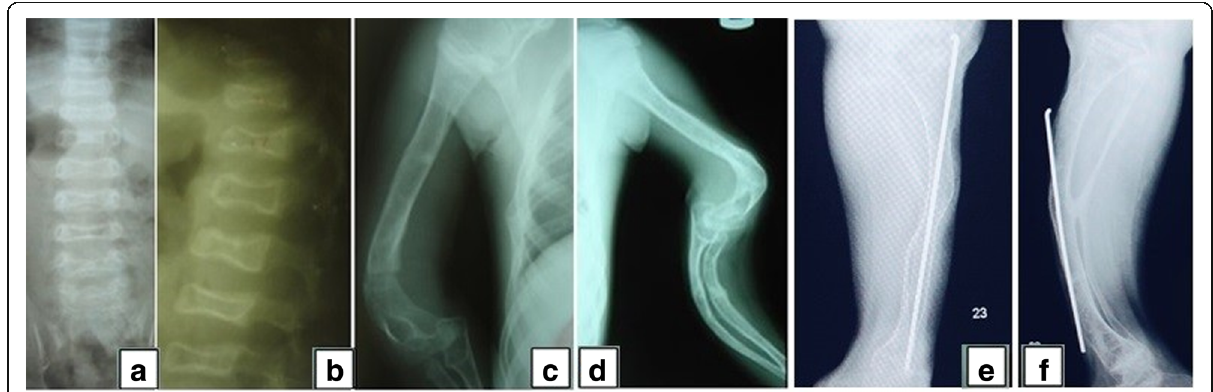
Fig. 1 Radiological features of the proband. Imaging of the thoracic and lumbar spines at 14 months of age, a the antero-posterior and b lateral views revealed depressed multiple vertebrae. Figures c-f showed imaging at 14 years of age of upper extremities ( c-d ) and lower extremities ( e-f ) revealing deformities of humeri, left ulna and radius, right tibia and fibula, left tibia and fibula,